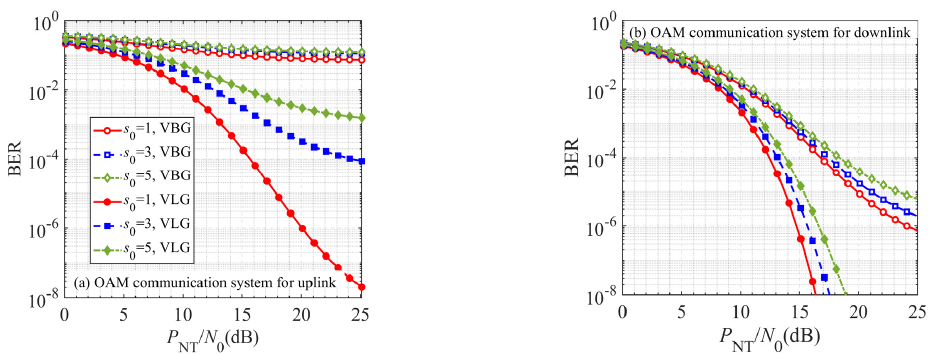
Figure 9. Average BER of air–ground OAM communication systems versus P NT / N 0 with different s 0 for uplink ( a ) and downlink ( b ).